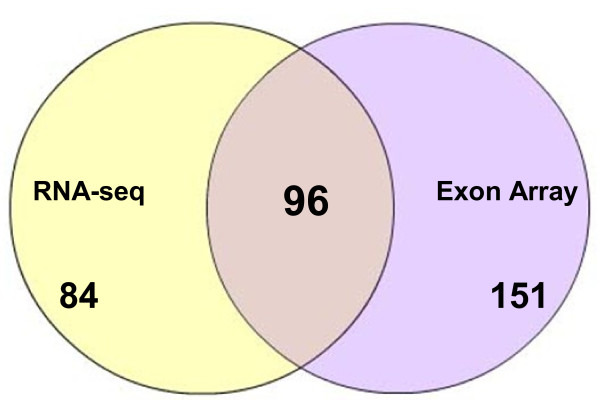
Venn diagram showing the 331 differentially expressed genes between SCD and Healthy Controls for RNA-seq and microarray. Gene selection Criteria for RNA-Seq -FC greater than or equal to 4; Exon array -FC greater than or equal to 2.